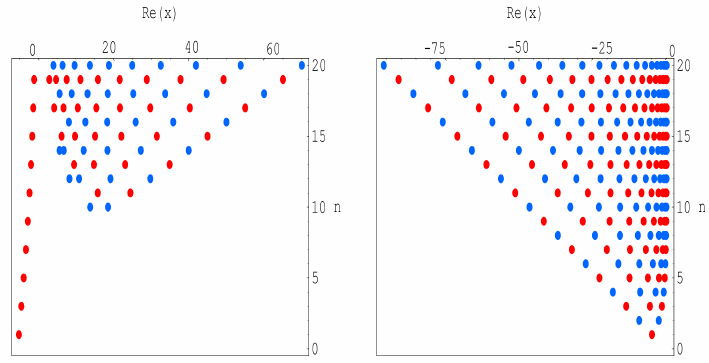
Figure 4. Stacks of zeros of G n ( x , r , β ) = 0,1 ≤ n ≤